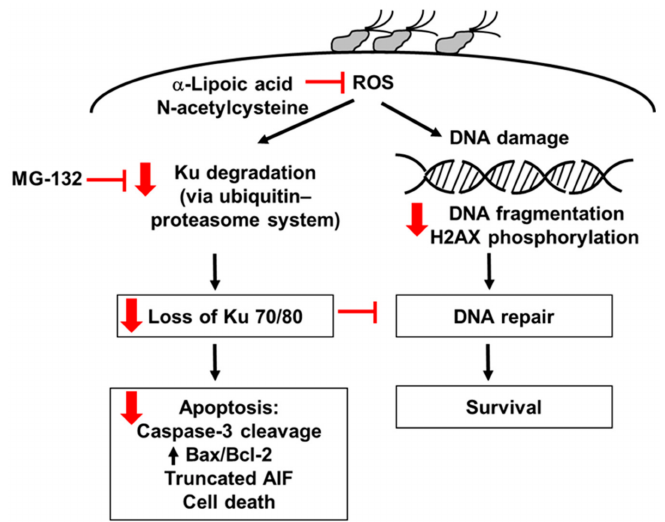
Figure 6. The proposed mechanism through which α -LA inhibits the loss of Ku proteins and apoptosis in H. pylori -infected cells. H. pylori increases ROS, which induces the degradation of Ku70/80 via the ubiquitin–proteasome system, resulting in the loss of nuclear Ku70/80 in H. pylori -infected cells. H. pylori increases oxidative DNA damage, determined by DNA fragmentation and H2AX phosphorylation in AGS cells. Loss of Ku proteins decreases the DNA repair process and induces apoptosis, assessed by increased Bax/Bcl-2, caspase-3 cleavage, truncated AIF, and cell death, in H. pylori -infected cells. α -LA reduces ROS levels and inhibits Ku degradation, loss of Ku70/80, DNA fragmentation, and apoptosis of H. pylori -infected cells. The antioxidant N-acetylcysteine and proteasome inhibitor MG-132 suppresses the degradation of Ku70/80 and apoptosis in H. pylori -infected cells. Red arrows represent the effect of α -LA. Red blocks mean “inhibition”. AIF, apoptosis-inducing factor; ROS, reactive oxygen